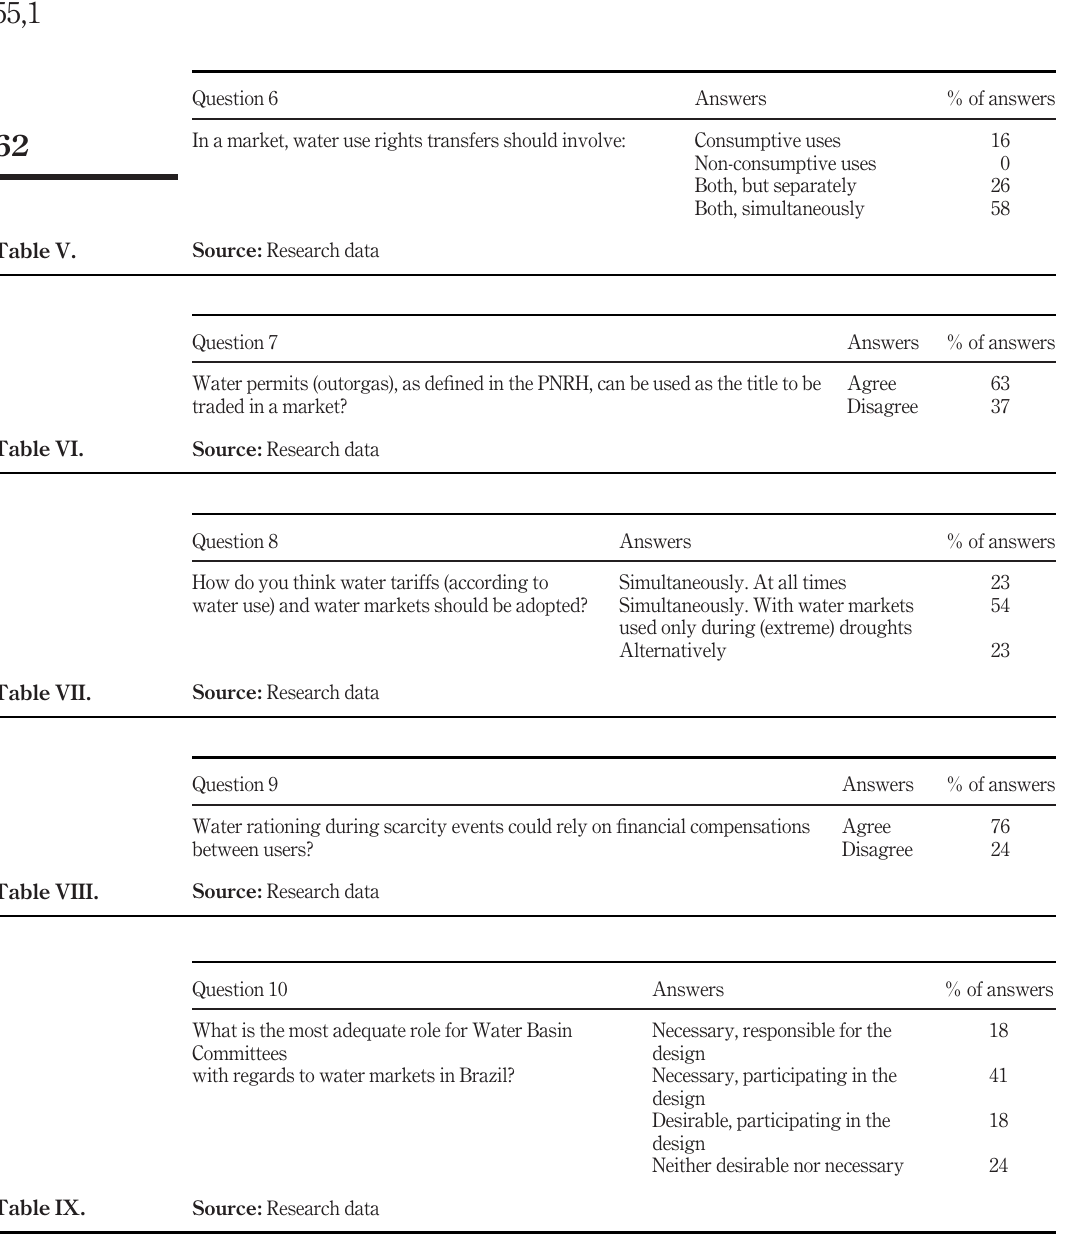
Question 6 Answers